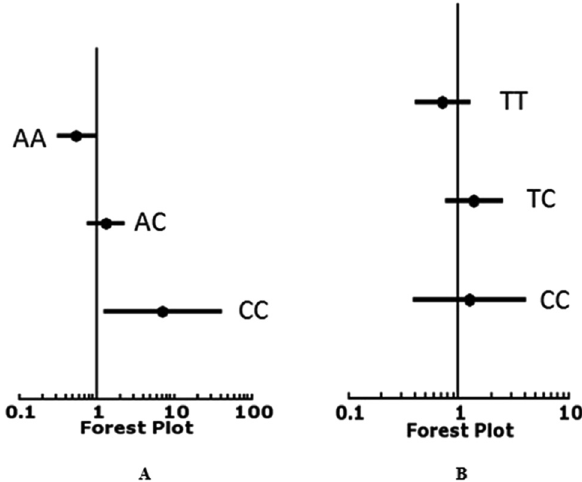
Figure 2: Forest plots for odds ratio values. (A) Forest plot rs889312 ( MAP3K1 ). (B) Forest plot rs11628333 ( MAP3K9 ).